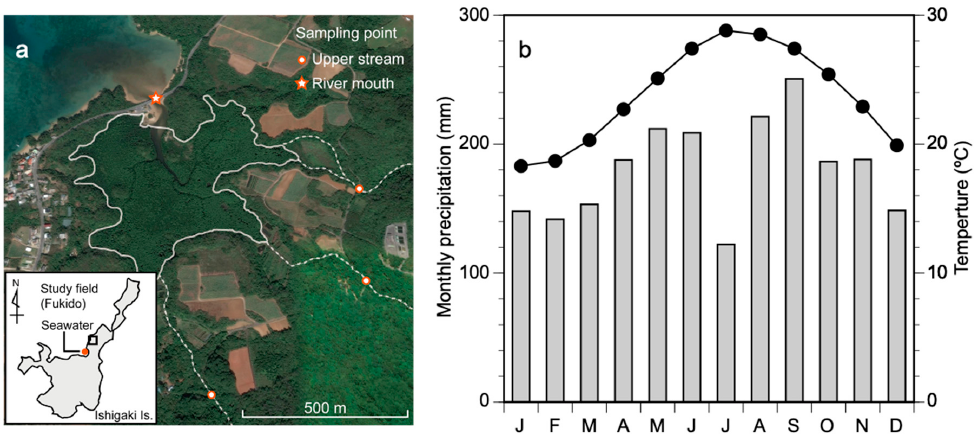
Figure 1. Site maps and sampling points of water ( a ). The white solid line indicates the mangrove estuary, while dotted lines indicate the inflowing upper streams. Map data provided by Google Earth. Monthly precipitation and monthly mean air temperature ( ● ) near the study site ( b ). Data were obtained from a weather station (Ibaruma) located approximately 5 km from the study area.